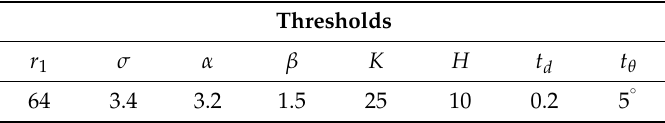
Table 5. Threshold setting of the proposed method.